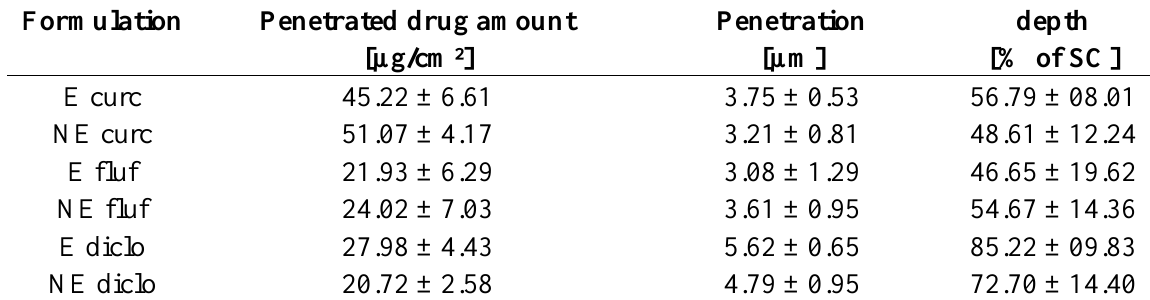
Table 6. Skin penetration data of curcumin (curc), flufenamic acid (fluf) and diclofenac acid (diclo) from macroemulsions (E) and nanoemulsions (NE) as determined by tape stripping. At least six experiments were performed for each formulation (n ≥ 6); indicated values are means ±